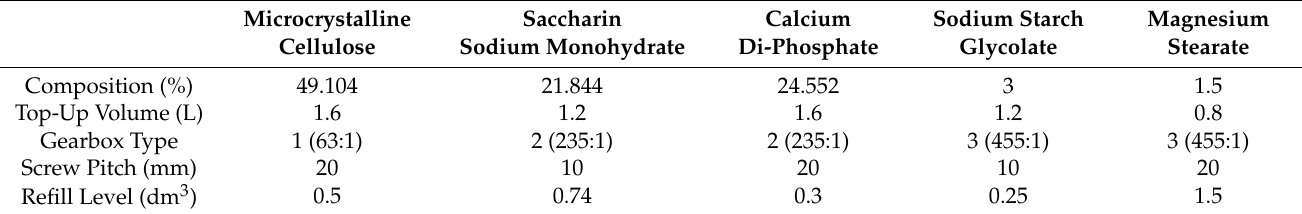
Table 3. Feeder settings for each raw